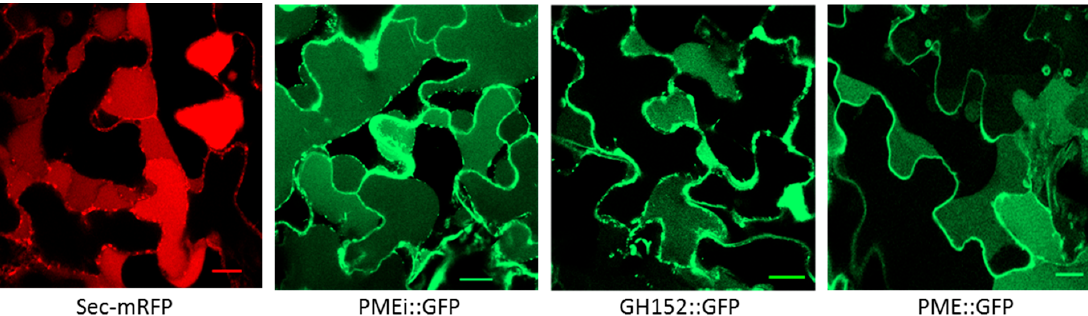
Figure 3. Subcellular localization of a PMEI (A0A1D6BK49), a GH152 (A0A1D6DD47), and a PME (A0A1D5V0T8) fused to a green fluorescent protein (GFP) in plasmolyzed N. tabacum leaf epidermal cells. Confocal images of plasmolyzed cells expressing the apoplastic marker Sec-mRFP, PMEI::GFP, GH152::GFP, and PME::GFP in leaf epidermal cells 2–3 days after agroinfiltration. Scale bars: 20 μ m.